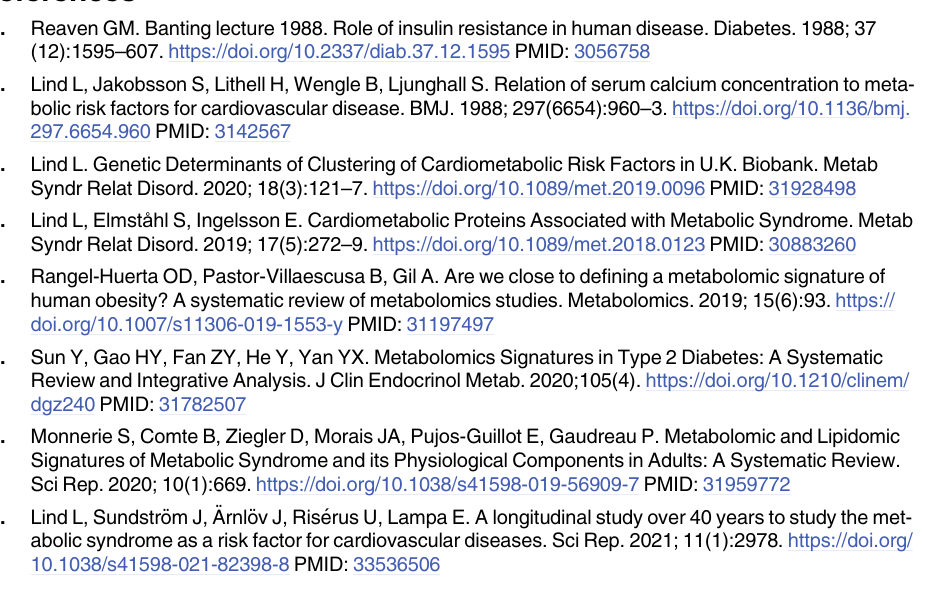
S1 Table. Overview of the metabolites being associated with at least one of the five MetS criteria. The criteria are given together with sum of criteria. The table was sorted on sum of criteria. S2 Table. Relationships between the 15 validated metabolites being related to all five com- ponents in the metabolic syndrome (MetS) and fasting glucose (GLU), HDL-cholesterol, systolic blood pressure (SBP), triglycerides (TG) and waist circumference (WC). The esti- mates are from the validation step in the SCAPIS-Malmo¨ cohort. No relationship for the metabolite glucose vs the GLU criteria is